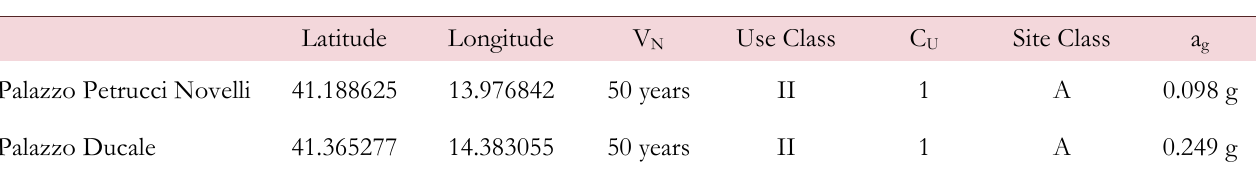
Table 1: Values of seismic parameters.